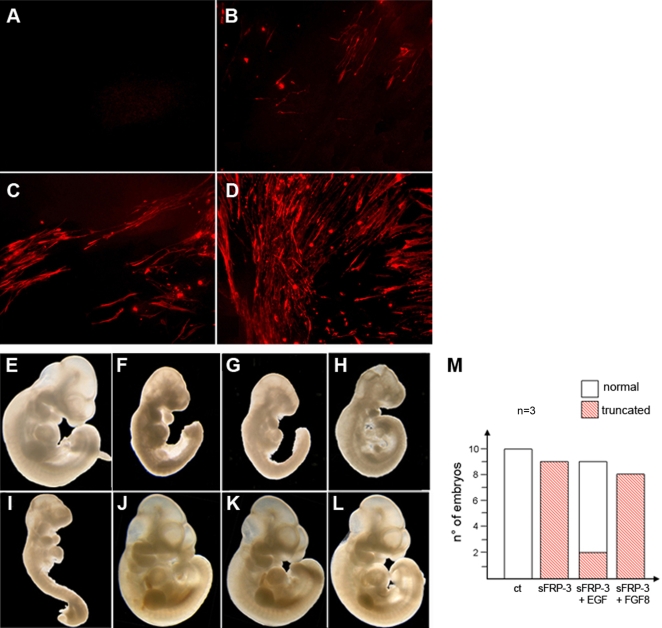
EGF reverts sFRP-3-induced inhibition of somitic myogenesis.(A–D) EGF reverts sFRP-3-induced inhibition of somitic myogenesis in explant cultures. MyHC antibody staining on explants cultures of presomitic mesoderm from E9.5 Myf5a2 embryos in the presence of sFRP-3 and EGF proteins. Mesoderm differentiation, which is almost completely abolished in the presence of sFRP-3 protein (A), is partially to fully restored when increasing amount of EGF are added to the culture (B–D: 50, 100 and 200 ng/ml), as revealed by the increasing number of positive MyHC fibers. (E–M) EGF rescues inhibition of myogenesis induced by sFRP-3 in vivo. (F,G) Transplacental delivery of s-FRP3 causes severe malformations of the caudal region of injected embryos. (J–L) Normal embryo morphology is restored when sFRP-3 is co-injected together with EGF, but not with FGF (H; I). (E) Control not-injected embryo. (M) Quantification of injected embryos with their relative phenotype in 3 independent, reproducible experiments.